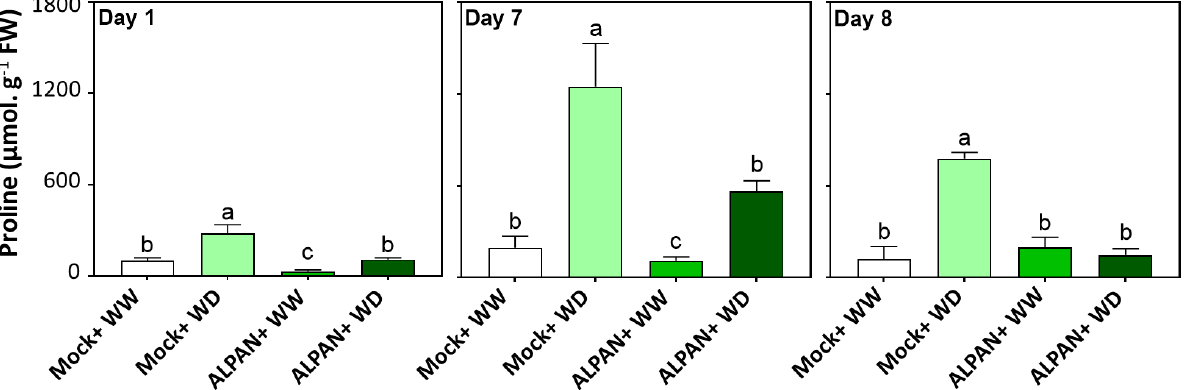
Figure 4. Proline concentration after 1, 7, and 8 days of the initiation of the water deficit stress. WW = well watered, WD = water deficit; FW = fresh weight. Error bars above histogram columns represent the standard deviation of four independent biological replicates in each experimental group at each sampling timepoint. The statistical data were analyzed with the use of the one-way ANOVA and Tukey’s post hoc tests, and a statistically significant difference ( p -value < 0.05) is denoted by a different letter above a histogram column.